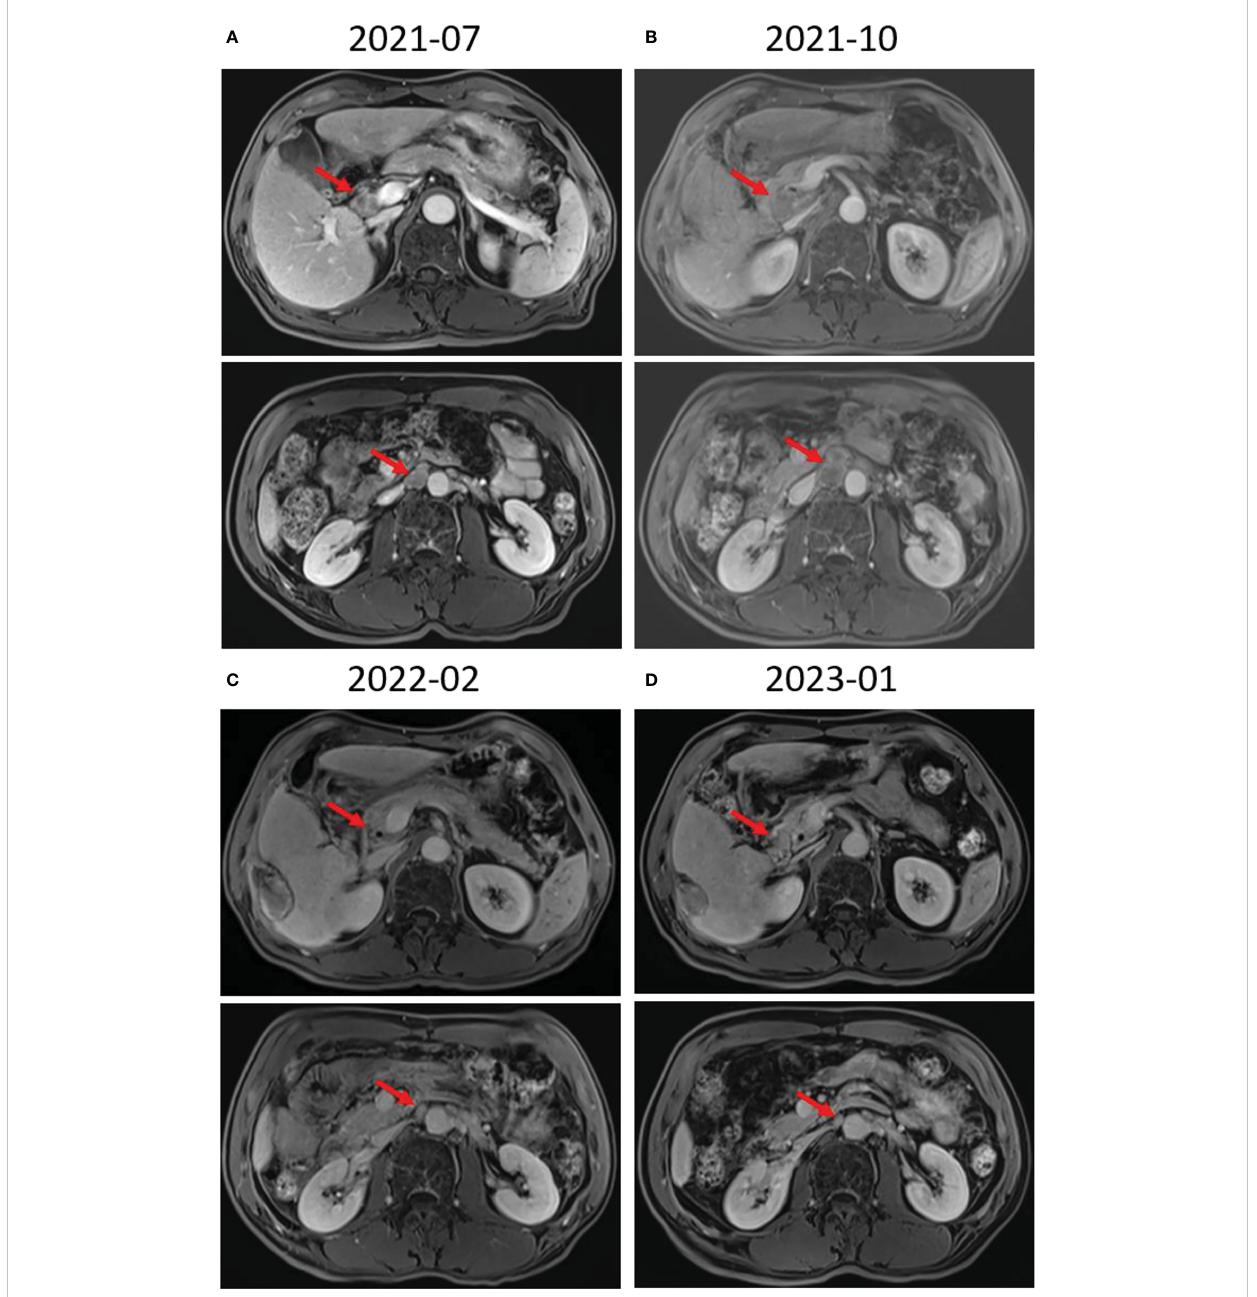
FIGURE 2 Radiological response evaluation of abdominal lymph nodes during the clinical course. (A) Contrast-enhanced magnetic resonance imaging (MRI) revealed multiple enlarged abdominal lymph nodes (red arrow). (B) Contrast-enhanced MRI showed that there were still multiple enlarged abdominal lymph nodes (red arrow) 3 months after surgical resection of lymph nodes in the hilar area. (C) Contrast-enhanced MRI showed that the size of the abdominal lymph nodes was reduced after RFA and four cycles of tislelizumab treatment (red arrow). (D) A signi fi cant reduction in the size of the abdominal lymph nodes ( ≤ 10 mm) was seen 15 months after tislelizumab treatment initiation (red